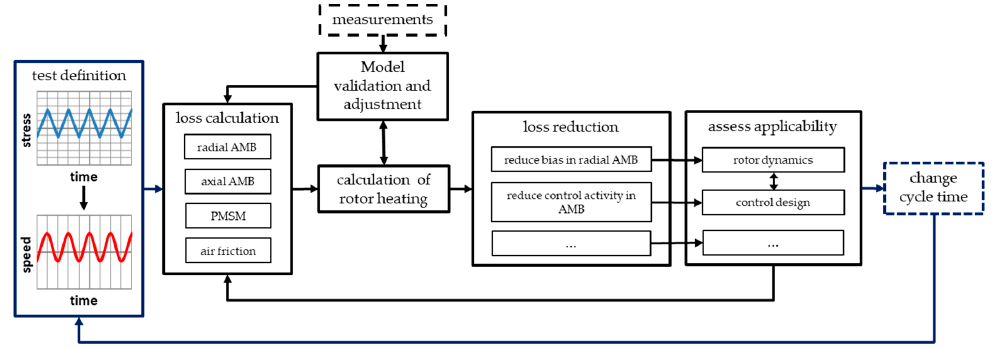
Figure 4. Applied approach to minimize the test duration by calculating and reducing rotor losses for the existing test rig. the existing test